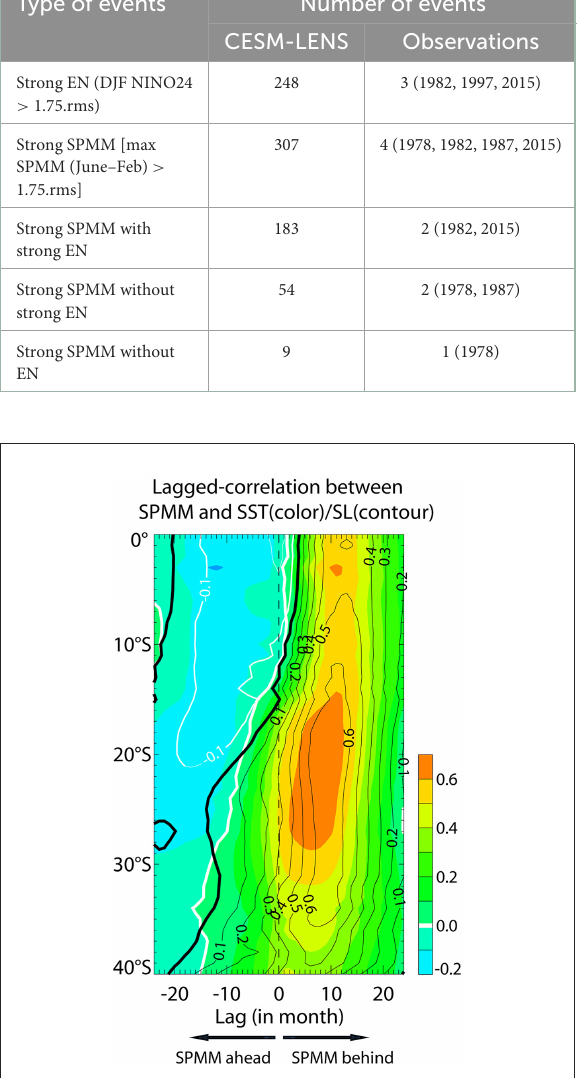
FIGURE5 Ensemble mean lagged-correlation between the SPMM index and SST (color)/SSH (contours) anomalies along the west coast of South America (2 ◦ -width coastal fringe) between 0 ◦ and 40 ◦ S. Positive lags indicate SPMM behind